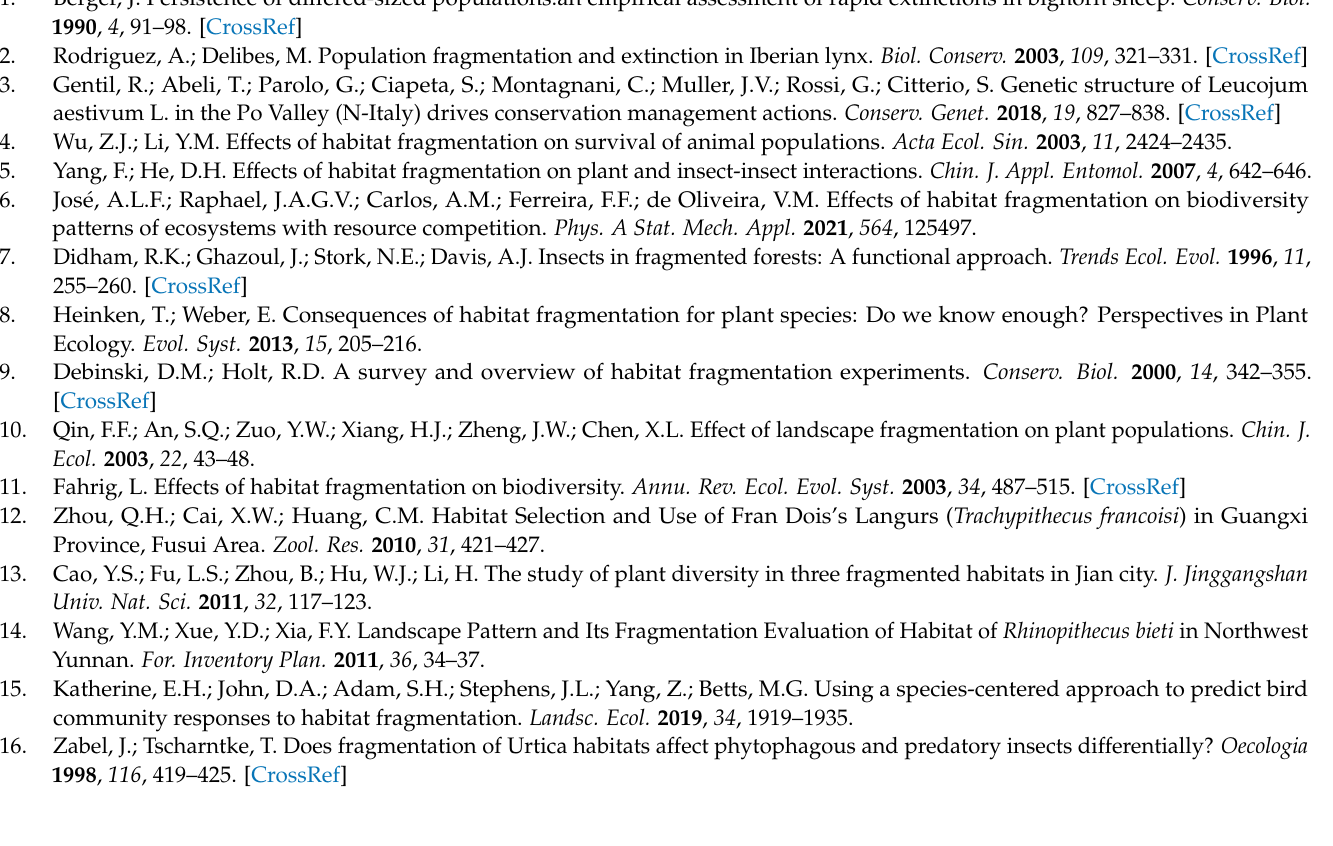
the sample plots. Table S8: Species diversity of leafhoppers in different sample plots of Shibing. Table S9: Species diversity of leafhoppers in different sample plots of Bijie. Table S10: Species diversity of leafhoppers in different sample plots of Huajiang. Table S11: Community diversity of Ery- throneurine leafhoppers in different study areas. Table S12: Community diversity of Erythroneurine leafhoppers in each sample plot. Table S13: Gammast and Fst values of fragmented populations of Erythroneurine leafhoppers in the study area. Table S14: Measured values of environmental factors in different study areas and